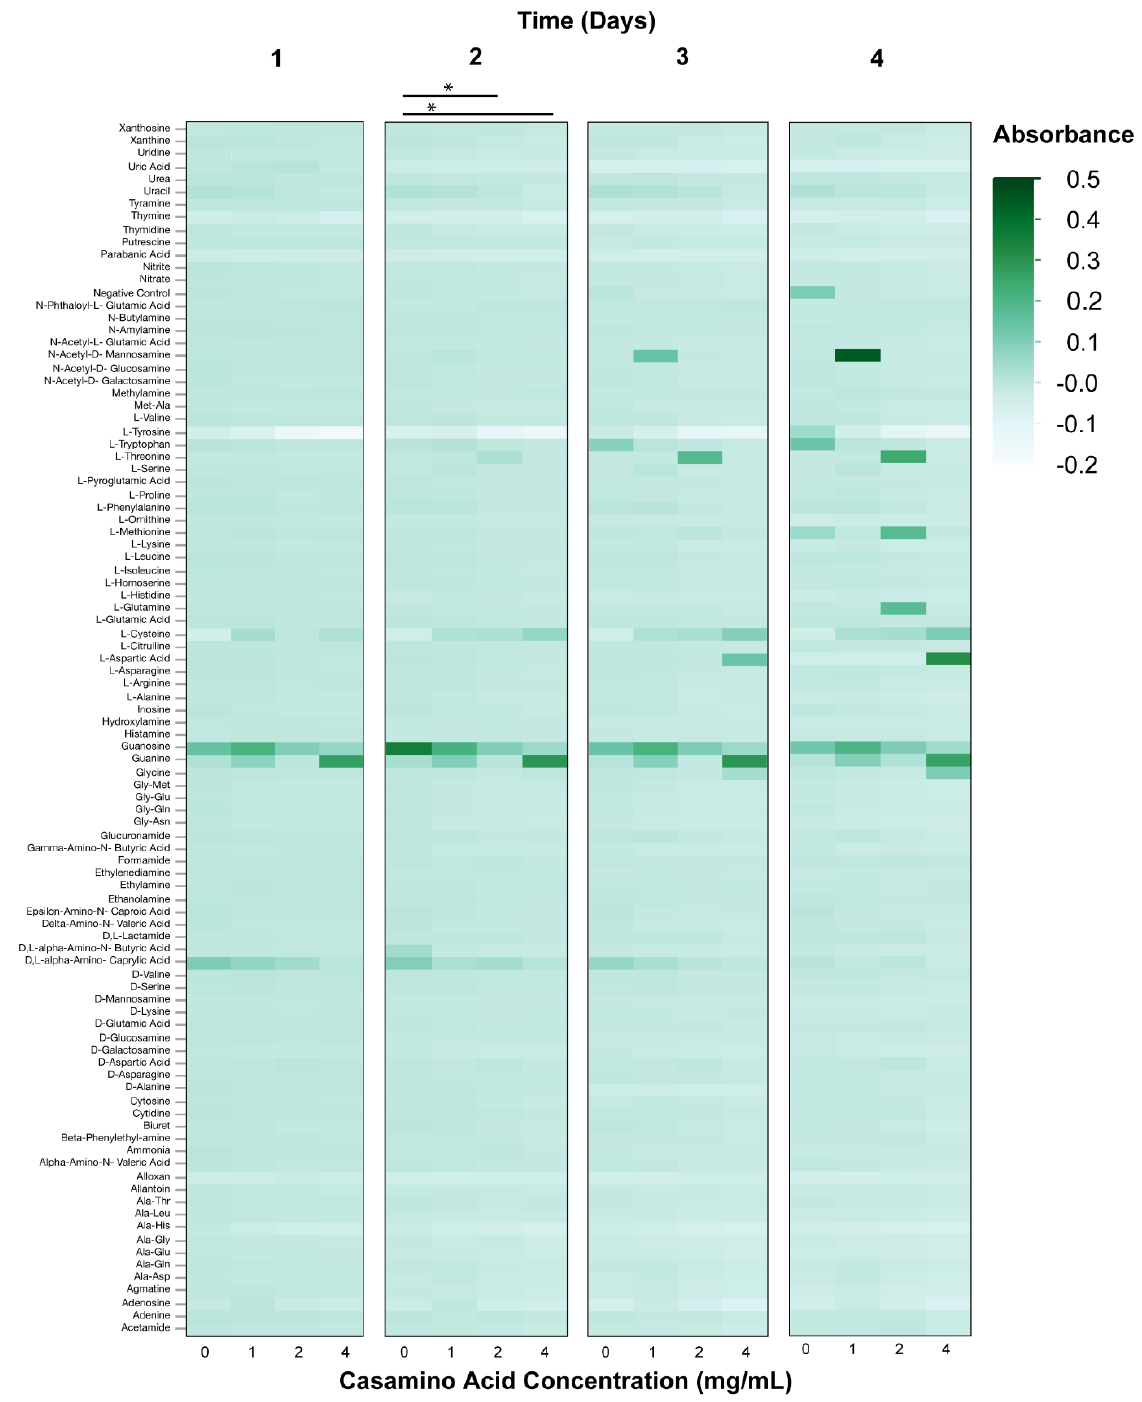
Figure 5. Heat map of PM3 phenotypic microarray data from Wolbachia isolated and maintained in Schneider’s medium supplemented with 10% FBS and different concentrations of Casamino acids ( n = 3 for each treatment). All data were normalized by subtracting absorbance values of control plates containing Schneider’s medium only from absorbance readings of treatment plates. Significant differences between treatments are represented by horizontal bars above each column for each timepoint (t-tests, * p < 0.05, ** p < 0.005, *** p < 0.0005).